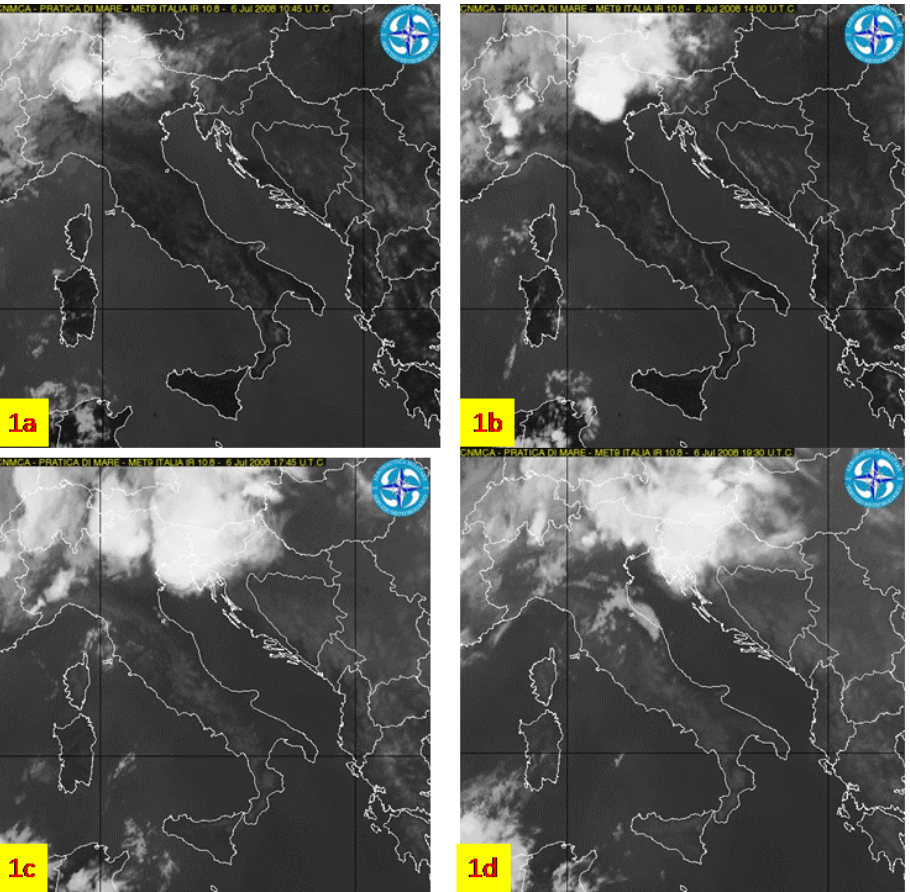
Fig. 1. Evolution of the mesoscale convective system in the afternoon of 6 July 2008. Infrared images. (a) spread thunderstorms begin on the Alps, (b) propagation and intensification of the phenomena on the North-East part of Italy, (c) the convective system has moved also Figure 1 – Evolution of the mesoscale convective system in the afternoon of July 6, 2008. Infrared on the Northern Adriatic Sea. Observe the “arc cloud”, a typical cloud band indicating the downdraft outgoing the thunderstorm, (d) with progressive attenuation the system moves towards Slovenia. The four images were taken at 10:45, 14:00, 17:45,